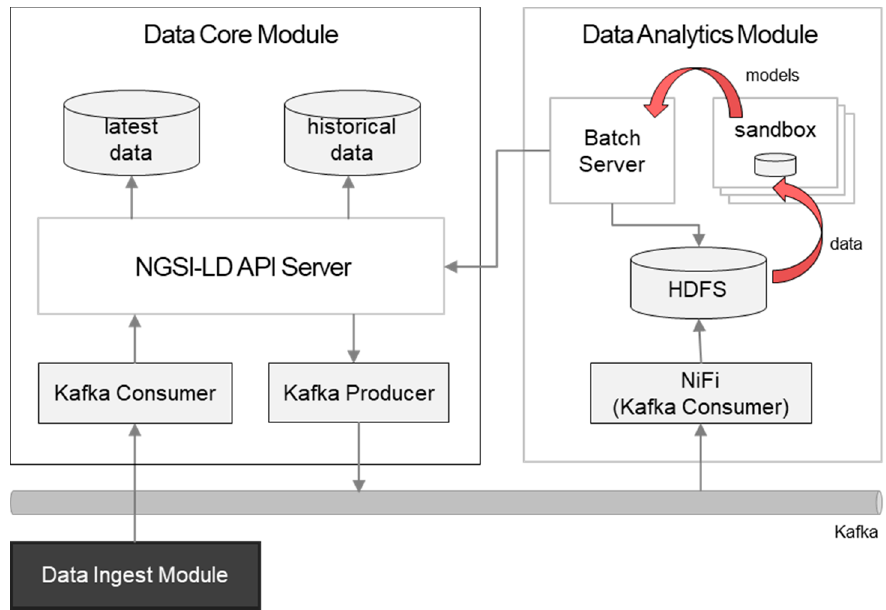
Figure 7. Interworking between the data core and analytics modules.